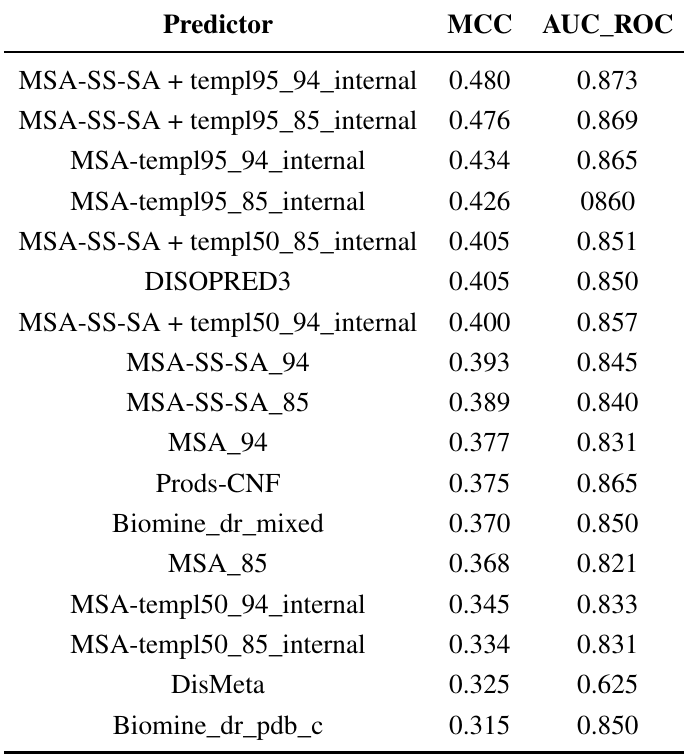
Table 6. Performances on the termini-trimmed targets obtained by all our versions and by top five CASP10 methods, derived from Monastyrskyy et al. (2014) [55], according to the MCC and AUC